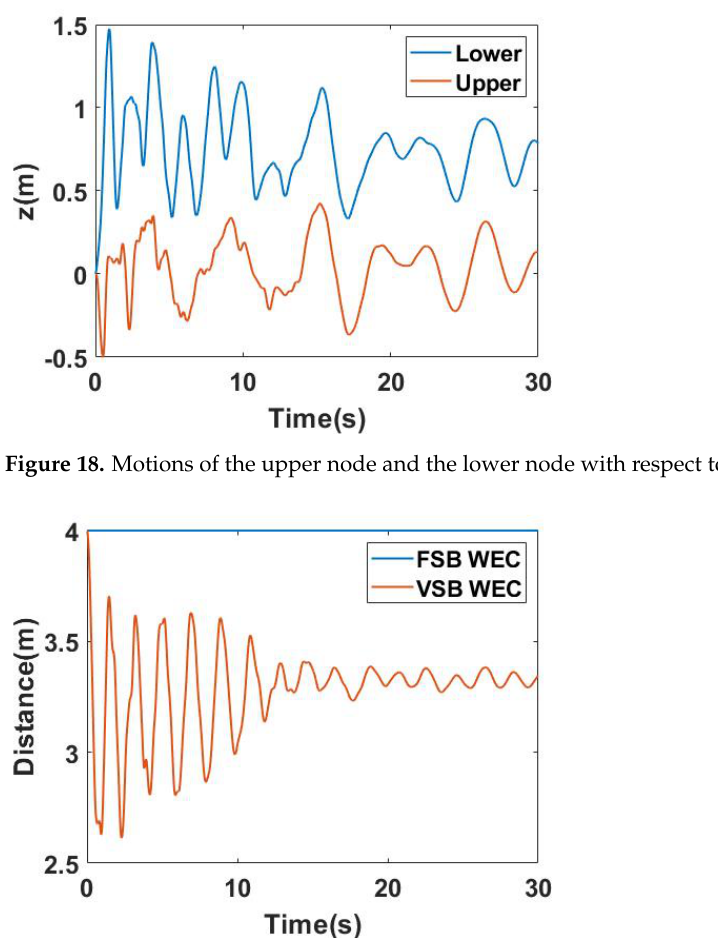
Figure 19. Relative vertical distance between the upper node and the lower node during